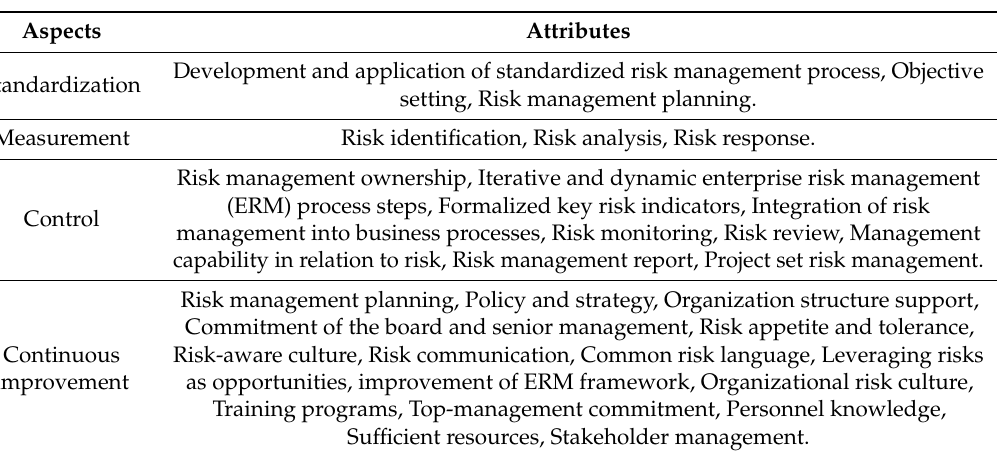
Table 3. Risk management aspects